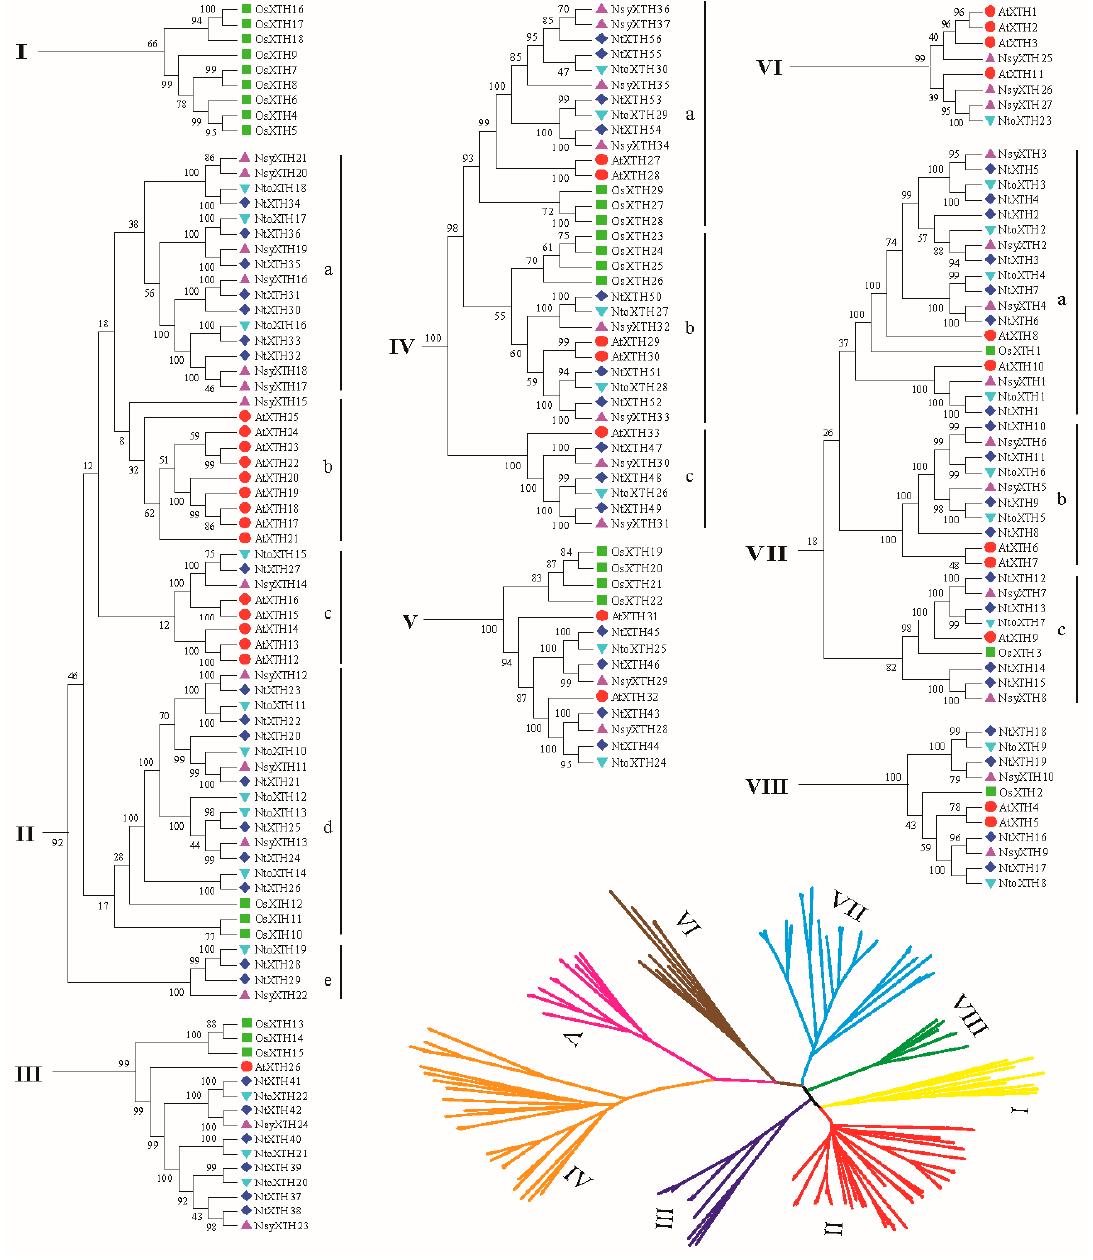
Figure 4. Neighbor-Joining phylogenetic tree of full-length XTH proteins in N . tabacum (dark blue diamond), N. sylvestris (purple triangle), N. tomentosiformis (light blue triangle) , Arabidopsis (red circle) , and rice (green square).